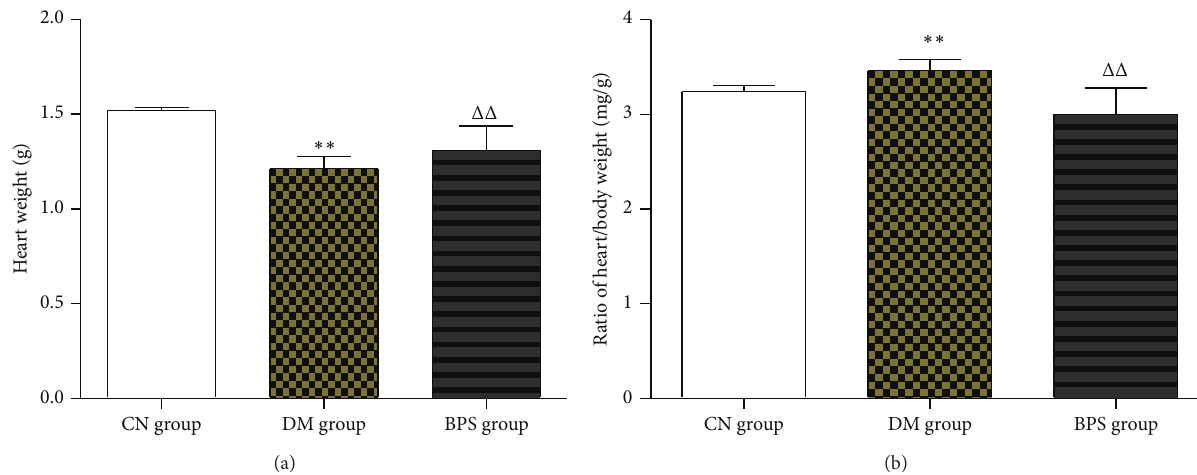
Figure 1: Heart weight and the ratio of heart-weight to body-weight in each group. Compared with the CN group, heart weight significantly decreased in the DM group ( 𝑃 < 0.01 ). Compared with DM group, heart weight increased in the BPS group ( 𝑃 < 0.01 ). Compared with CN group, the ratio of heart-weight to body-weight increased in both DM group and BPS group ( 𝑃 < 0.01 ). Compared with DM group, the ratio of heart-weight to body-weight decreased ( 𝑃 < 0.01 ) in BPS group. There was no statistical difference between BPS group and CN group about the ratio of heart-weight to body-weight.